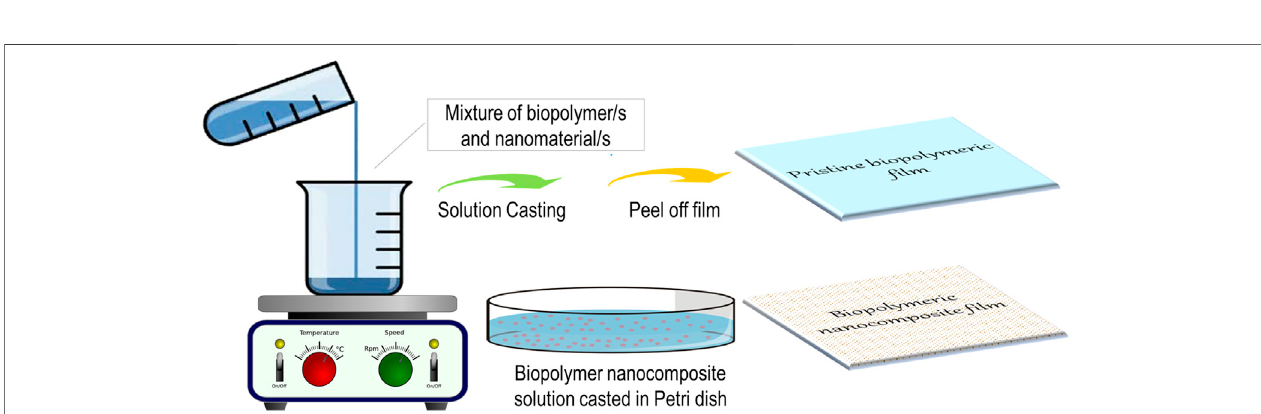
FIGURE 5 | General protocol for designing biopolymeric nanocomposite fi lms by solution casting method.